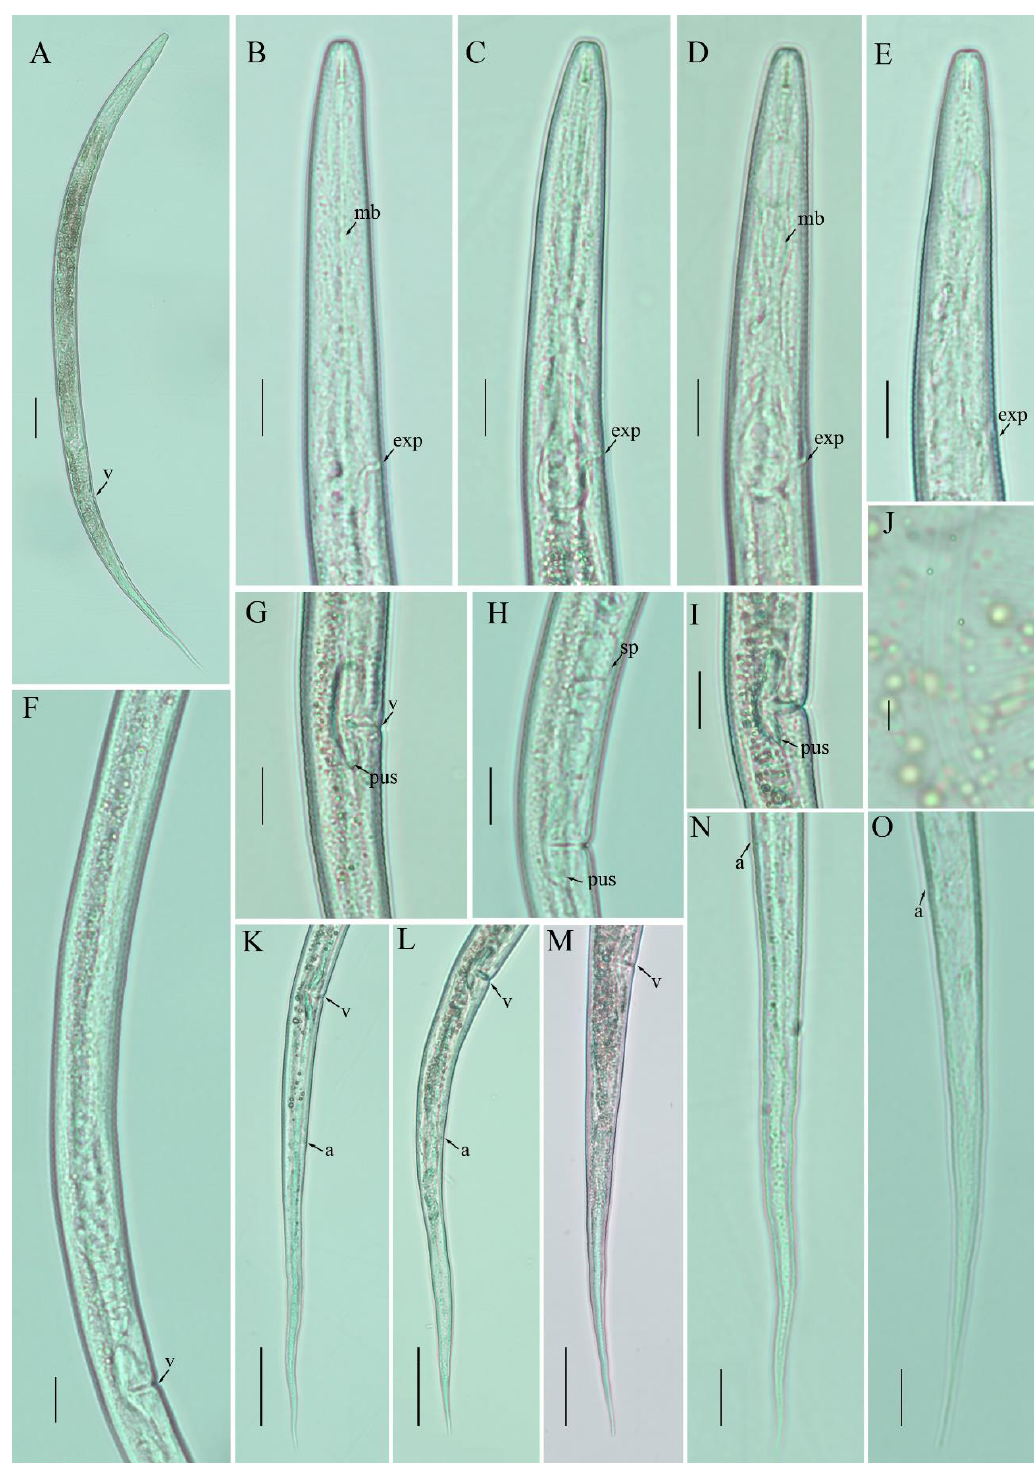
Figure 3. Photomicrographs of female Filenchus sheri (Khan and Khan) Siddiqi [21,22]. ( A ) Entire body; ( B – E ) pharyngeal regions; ( F ) gonad; ( G – I ) vulval regions; ( J ) lateral lines; ( K – O ) posterior body to tail terminus. Scale bars: ( A ) 50 µm; ( B – I , K – O ) 20 µm; ( J ) 5 µm. Arrowheads: (a) anus; (exp) excretory pore; (mb) median bulb; (PUS) post-uterine sac; (v) vulva.